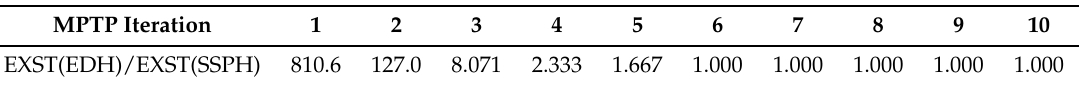
Table 11. Ratio between explored states for A* with EDH vs. A* with SSPH , if the aircraft can turn left and right.